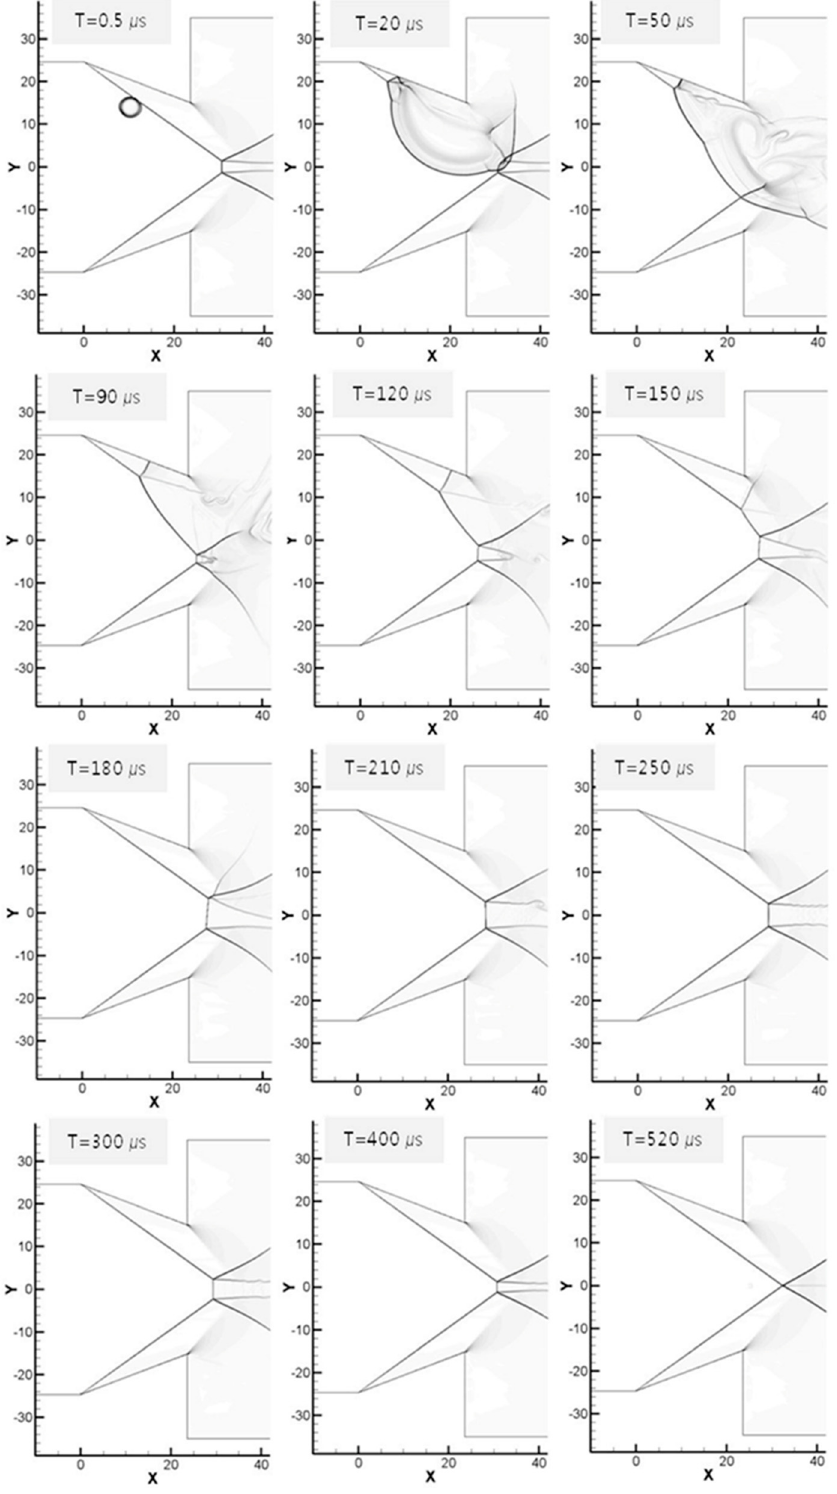
Figure 12. Interaction between blast wave and oblique shock, deposition at the middle of the upper wedge. Energy: 107.5 mJ.